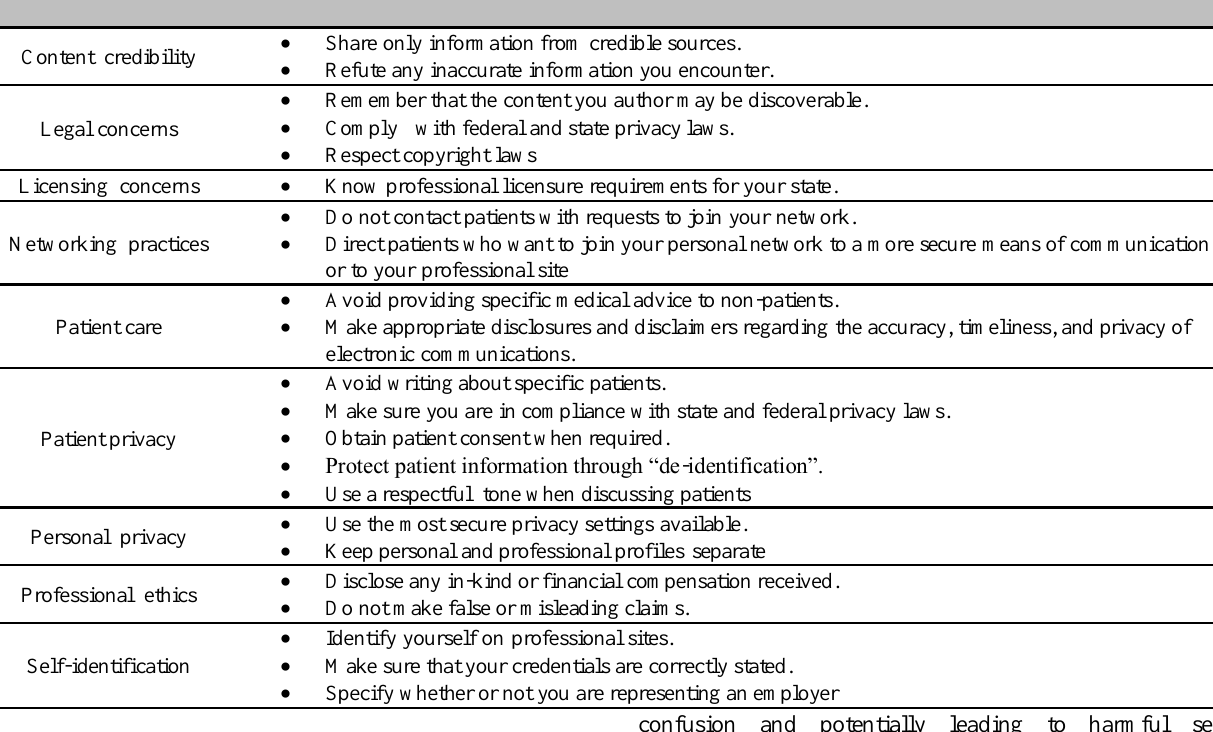
Table 4. Common Guidelines for the use of social media by HCPs